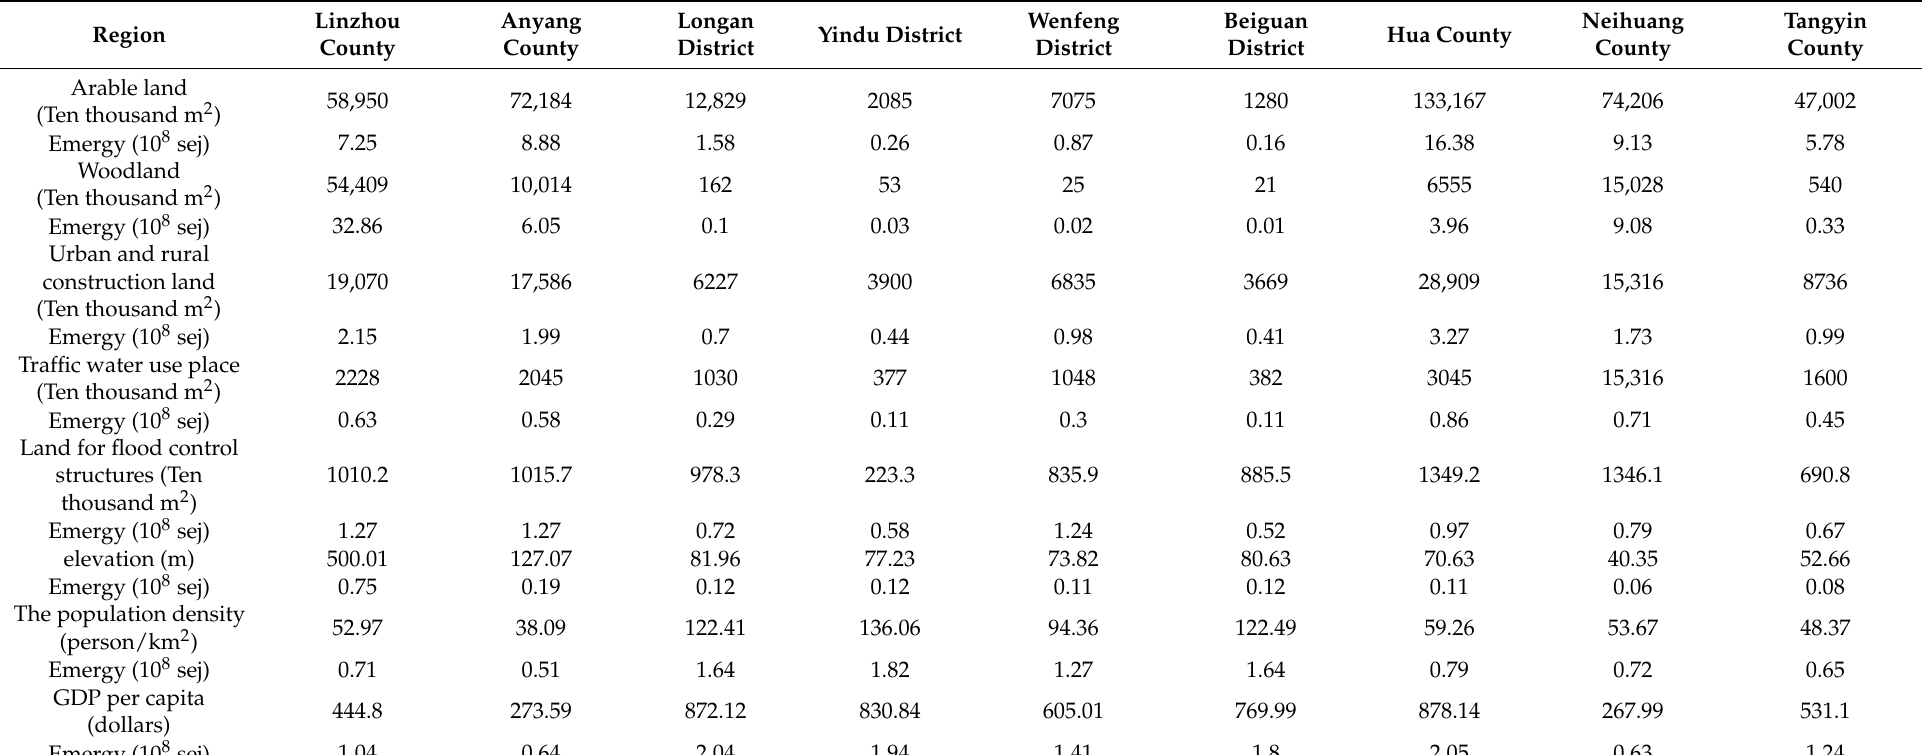
Table 3. Emergy conversion of different risk